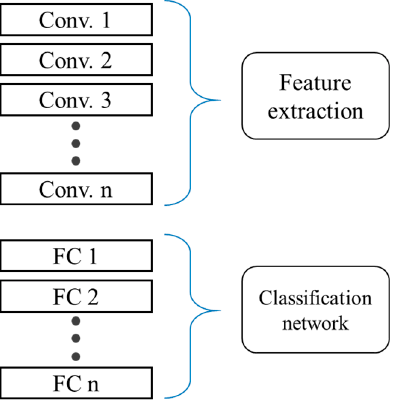
Figure 1. Architecture of the proposed pre-trained visual geometry group (VGG)-16.